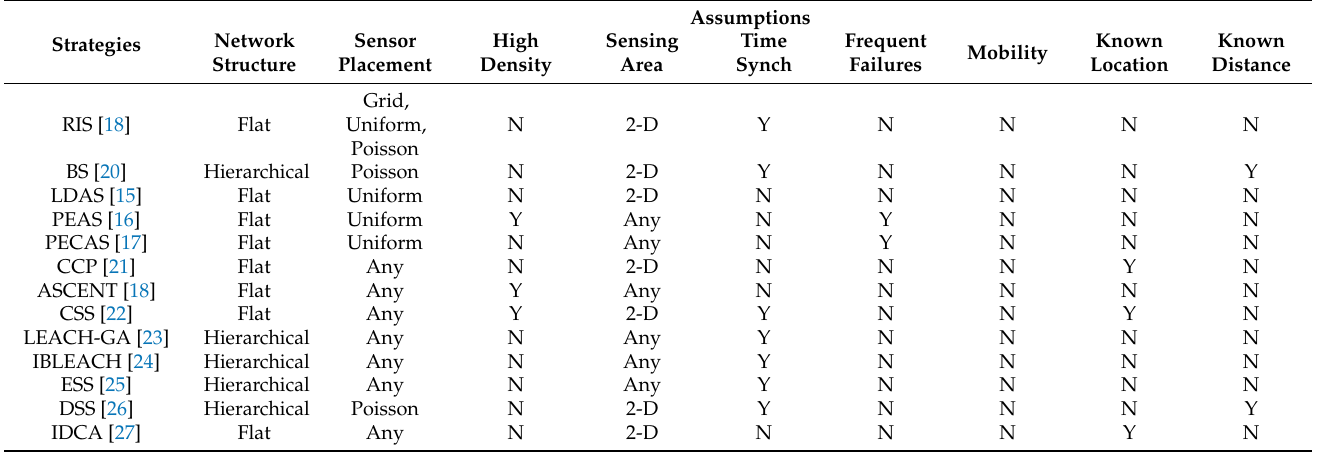
Table 1. The studies’ classifications according to their